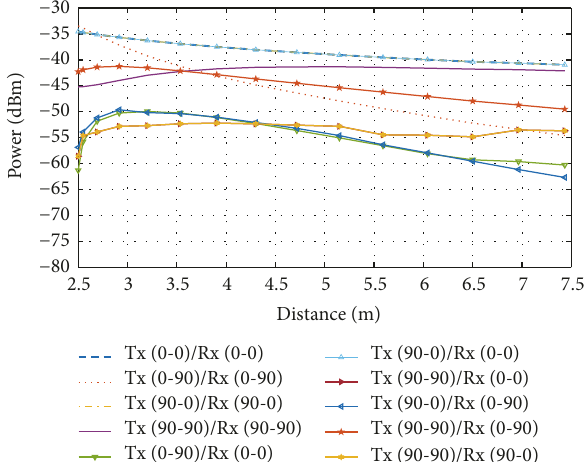
Figure 10: 𝑃𝑟 levels of all Tx and Rx combinations using the dipole antenna in the LOS